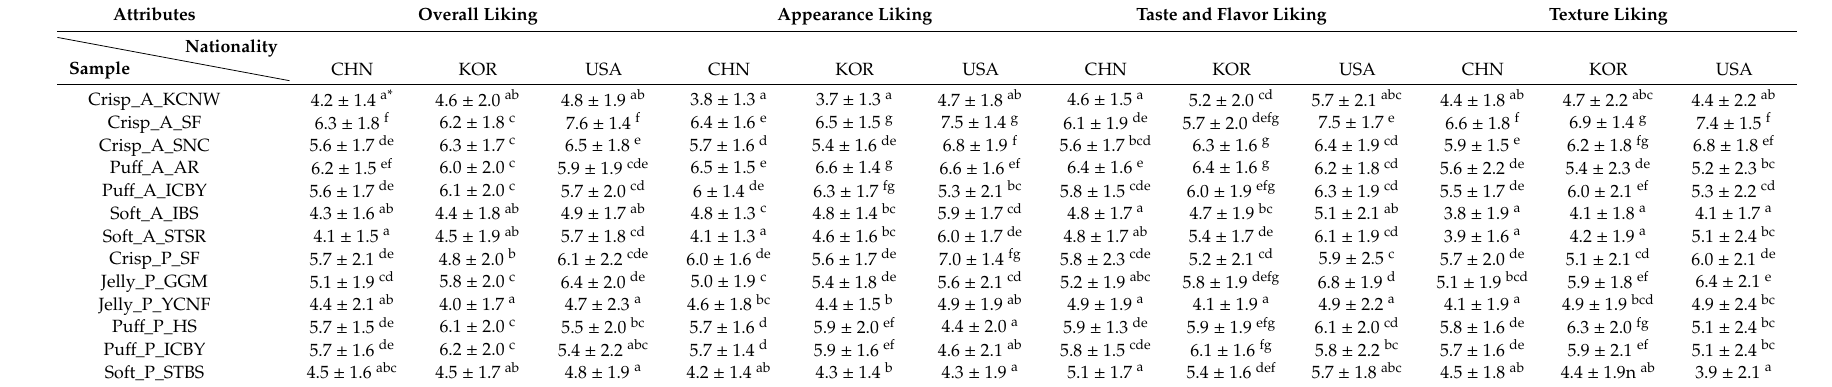
Table 4. Mean ± standard deviation of sample liking scores evaluated by Chinese, Korean, and US